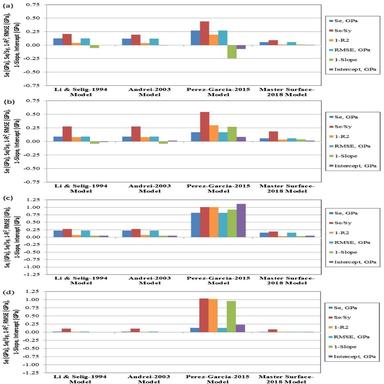
Bias and Precision Parameters for the Investigated Models a) Subgrade Materials, b) Granular Base Materials, c) Stabilized Materials, and d) Recycled PCC Material.